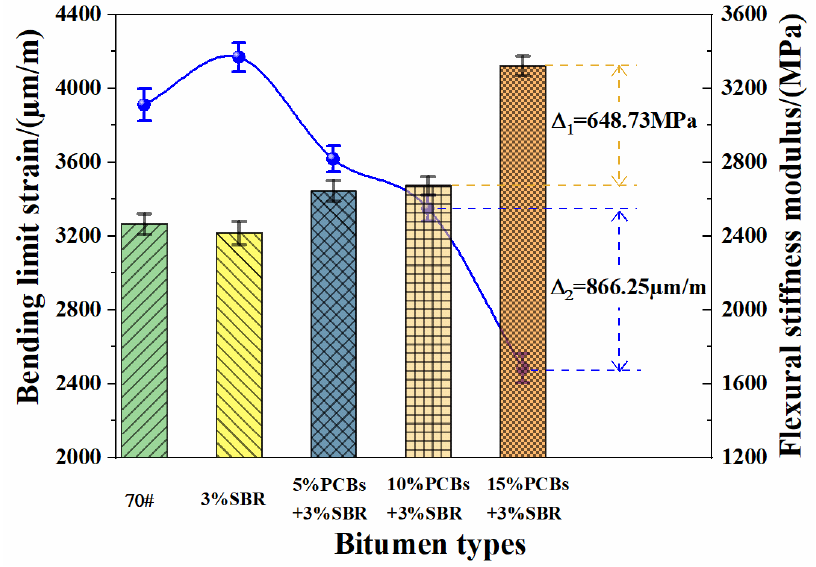
Figure 11. The results of bituminous mixture bending test in low